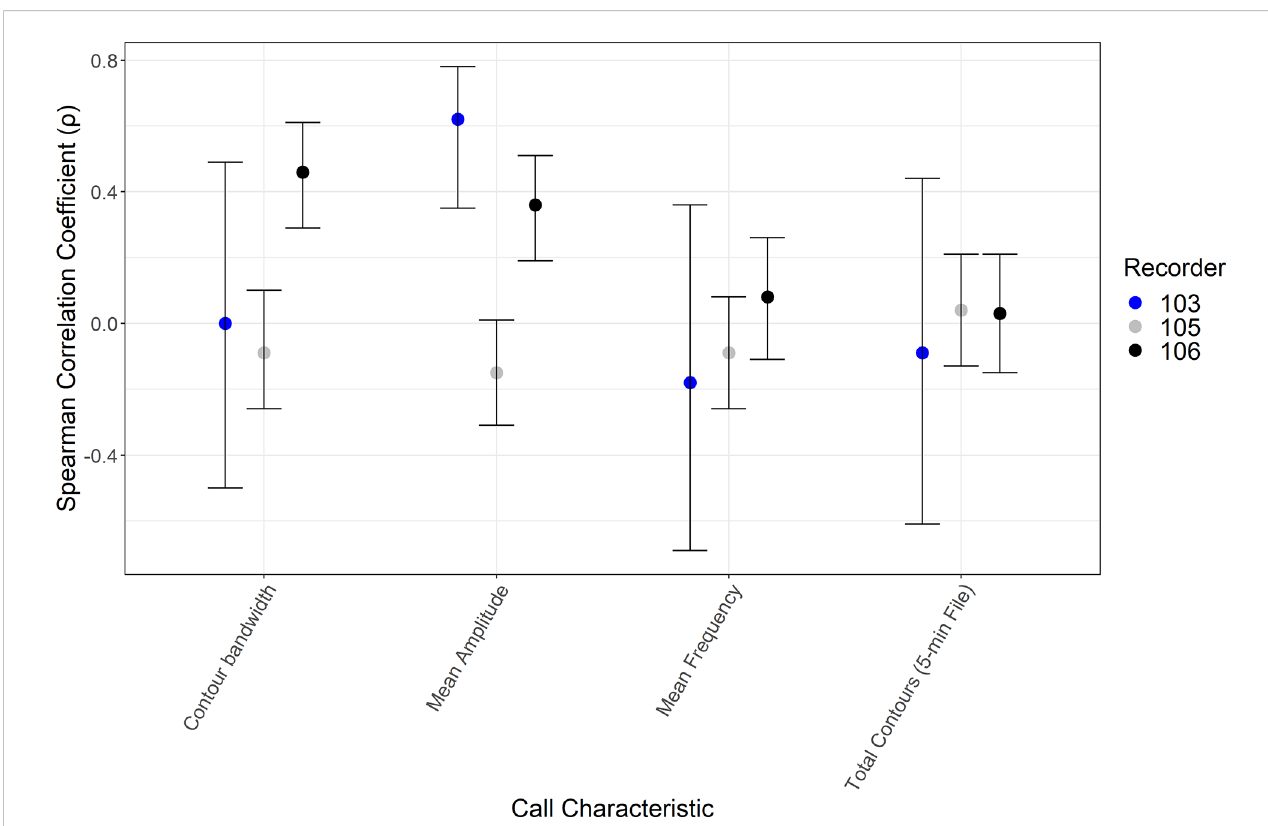
FIGURE 8 Results of the Spearman correlation coef fi cient ( r ) and bootstrapped con fi dence intervals comparing call characteristics of delphinid species to Acoustic Complexity Index. Characteristics of burst pulsed calls from delphinid species including mean measurements (per fi ve-minute fi le) of contour bandwidth, call amplitude, mean frequency and total number of calls are reported for the recorders at the base of the slope (103), the slope (105), and the shelf